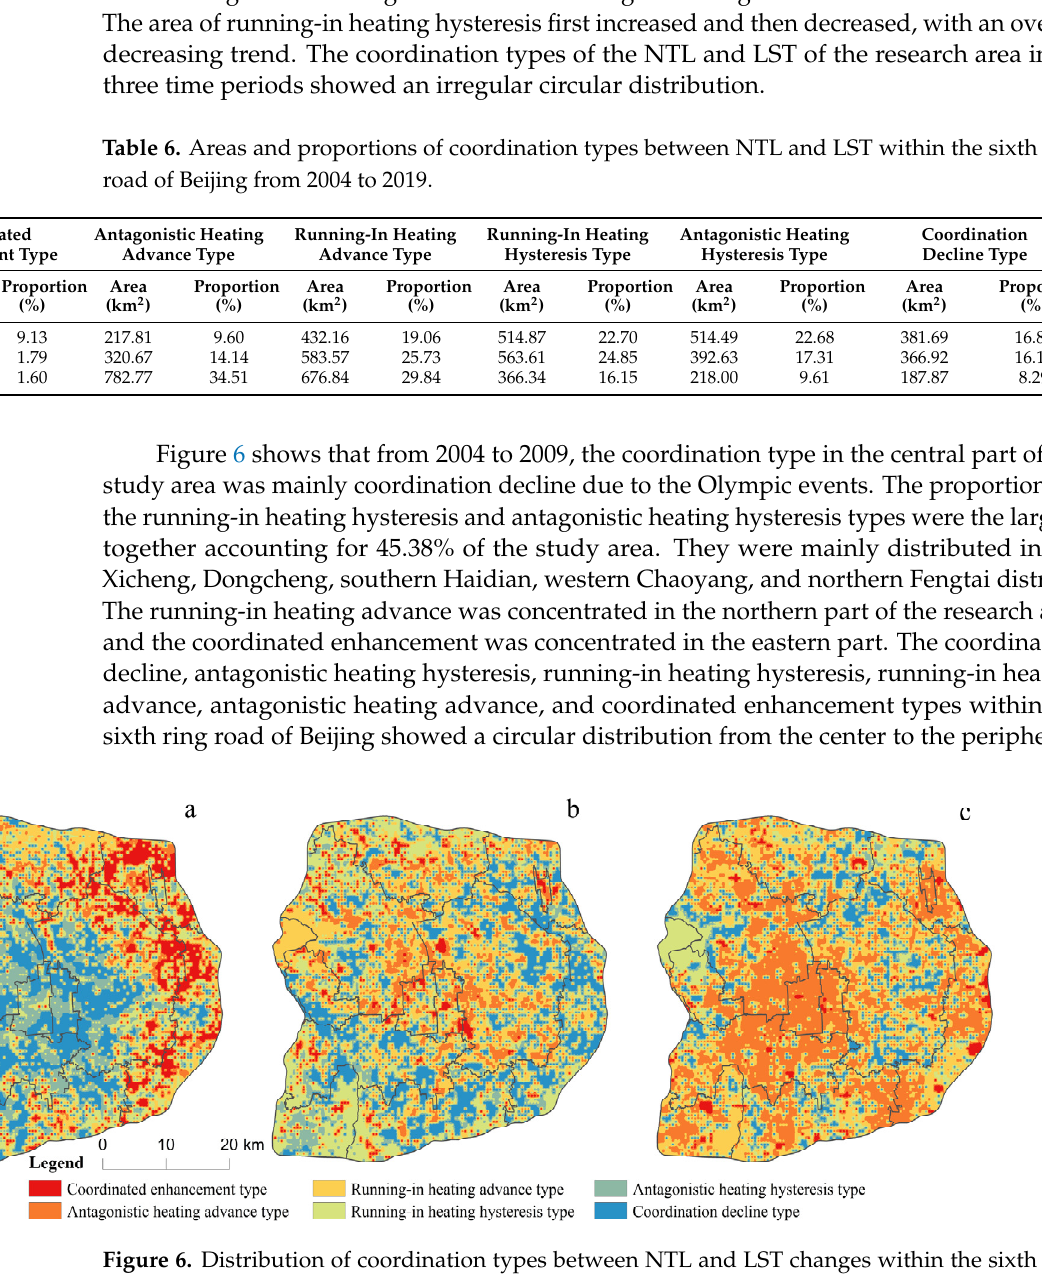
Table 5. Coupling analysis of the LST and NTL within the sixth ring road of Beijing from 2004 to 2019.